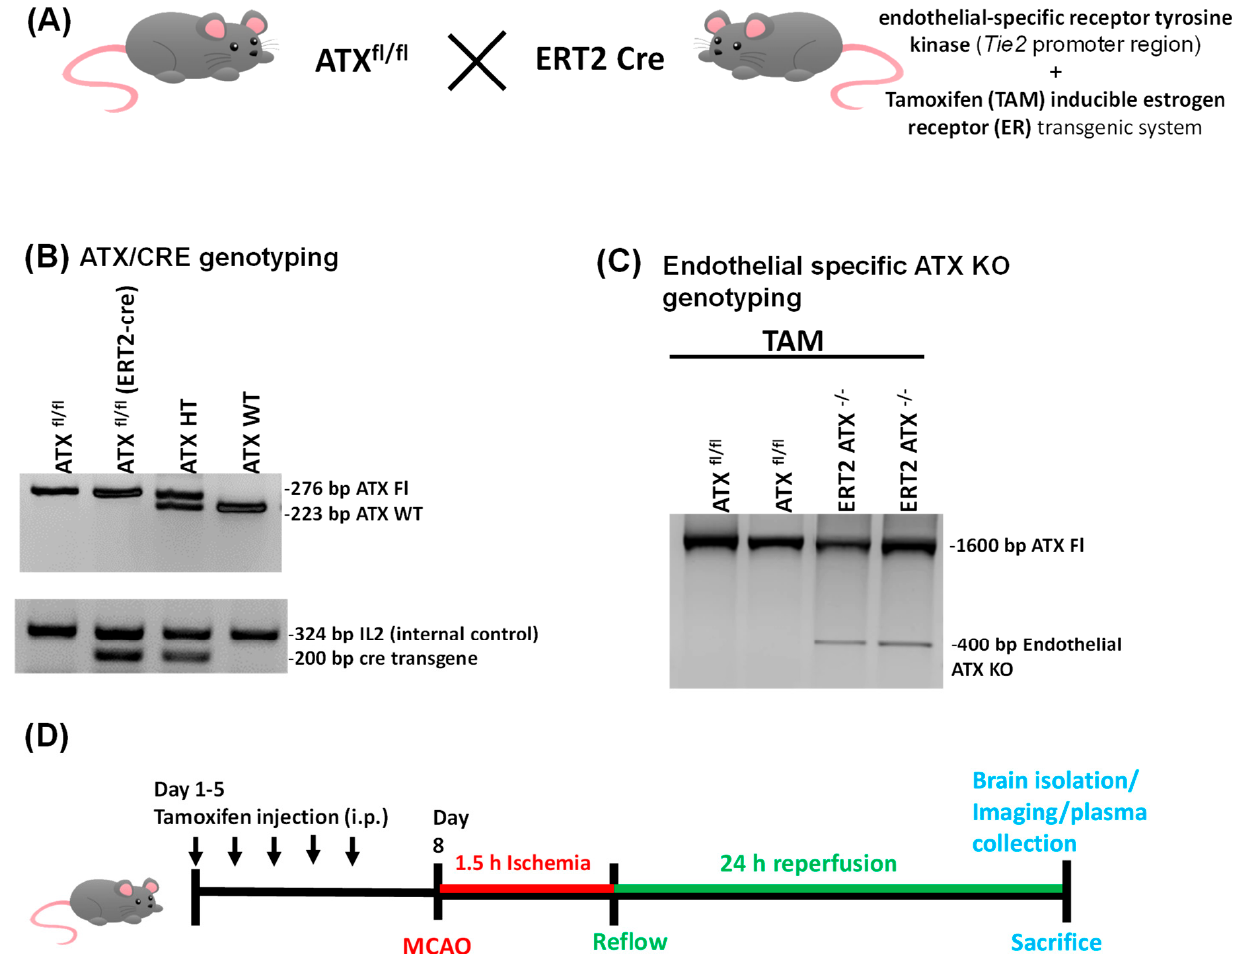
Figure 1. Generation and genotyping of endothelial-specific ATX knockout mice. ( A ) ATX flox (ATX fl/fl ) mice were bred with transgenic mice having an estrogen receptor-Cre fusion protein under the control of endothelial-specific receptor tyrosine kinase Tie2 promoter (ERT2 Cre mice) to generate tamoxifen (TAM)-inducible endothelial-specific ATX knockout mice. ( B ) DNA genotyping using primers for ATX and CRE to identify mice with Cre transgenic system plus ATX fl/fl system to induce TAM-mediated knockout for ATX. ( C ) Mice brain tissue genotyping to show endothelial-specific ATX is knocked out after injection of TAM in ERT2 ATX − / − mice. A band at 1600 bp shows the full ATX from other cells of the brain, and a 400 bp band is from the endothelial cells where ATX is knocked out after TAM injection. ( D ) Timeline representation of the experimental plan where mice were injected with tamoxifen for 5 days and then MCAO was performed in mice (1.5 h ischemia and 24 h reperfusion), followed by brain isolation for various experiments.